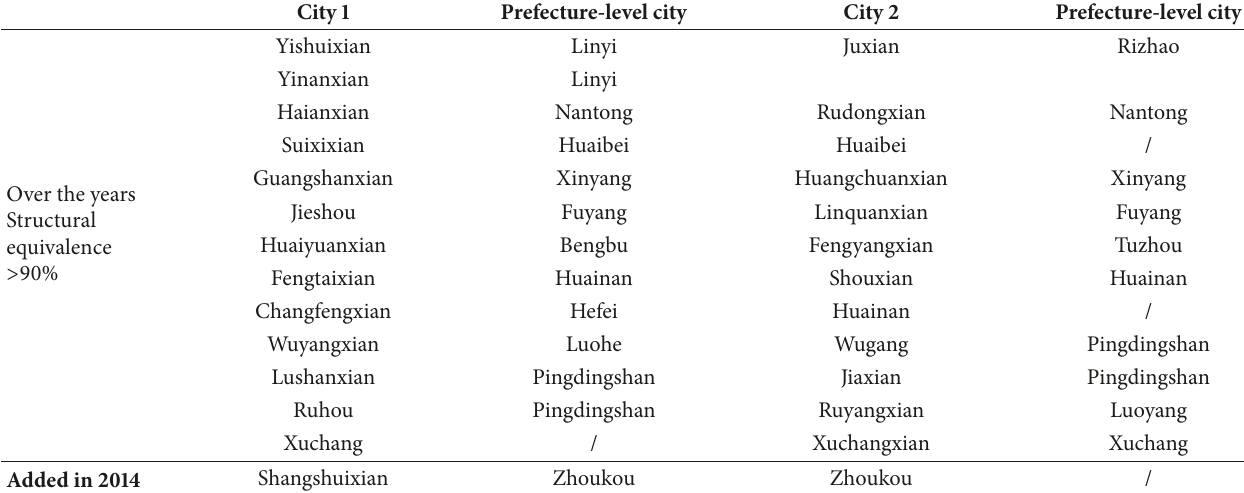
Table 9: Structural analysis results of the HRB